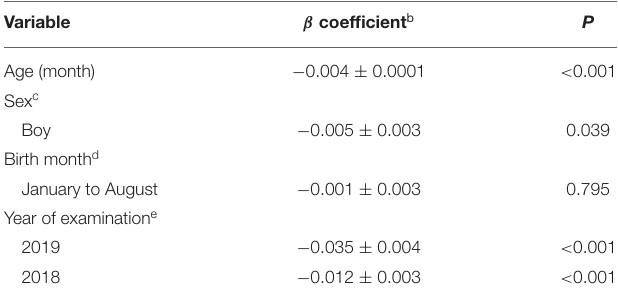
TABLE 3 | Linear mixed effects model assessing the effect of factors on uncorrected visual acuity a , adjusting for clustering effect on kindergartens and interocular correlation.